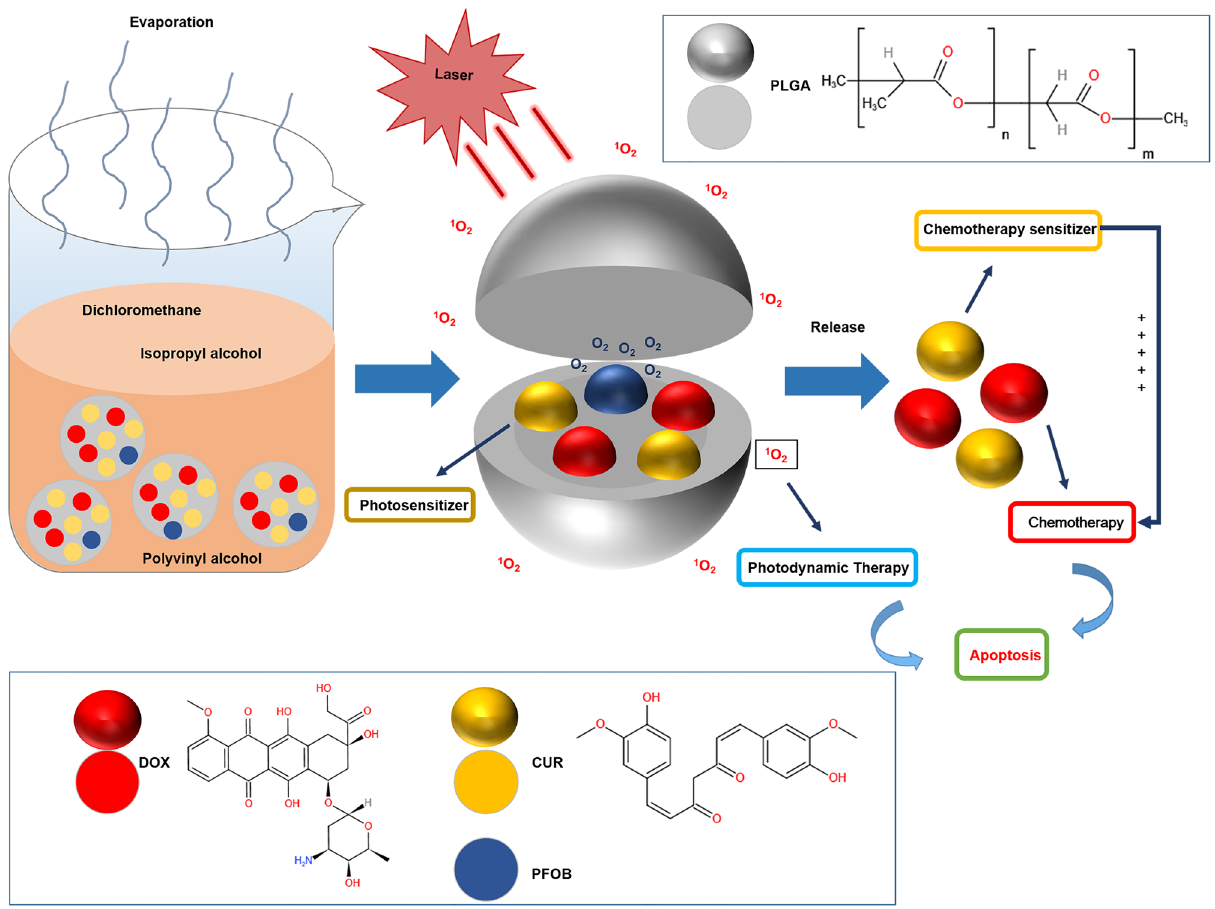
Figure 1. A schematic diagram of photochemical-responsive nanoparticles incorporating DOX, CUR, PFOB and PLGA and laser-triggered drug release induced apoptosis under the combined effect of PDT and chemotherapy. DOX: Doxorubicin; CUR: Curcumin; PLGA: Poly (lactic-co-glycolic acid); PFOB: perfluorooctyl